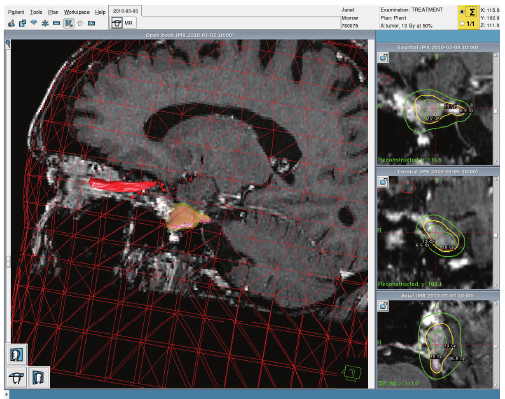
Figure 2: Three-dimensional rendering of the tumor in treatment planning of the patient’s first GKRS treatment; the tumor is high- lighted and is posteroinferior to the optic nerve which is also highlighted.